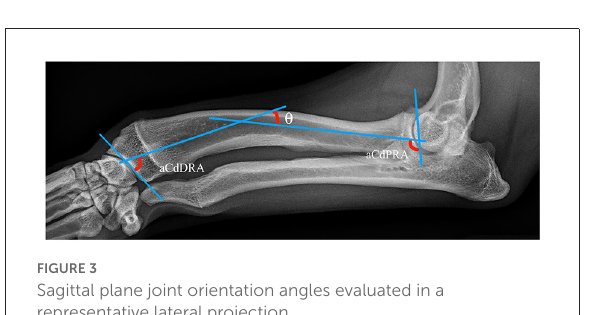
FIGURE3 Sagittal plane joint orientation angles evaluated in a representative lateral